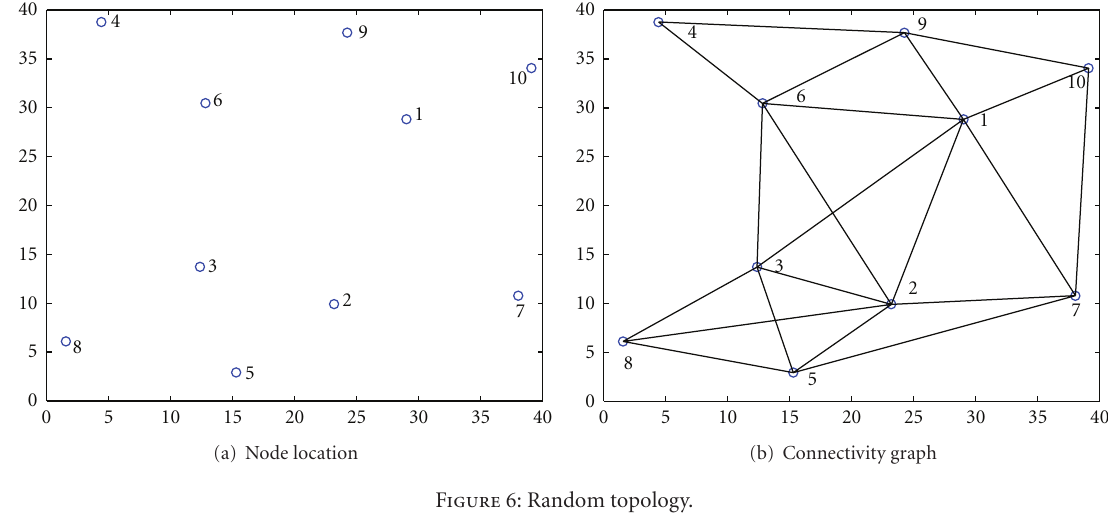
Figure 6: Random topology.